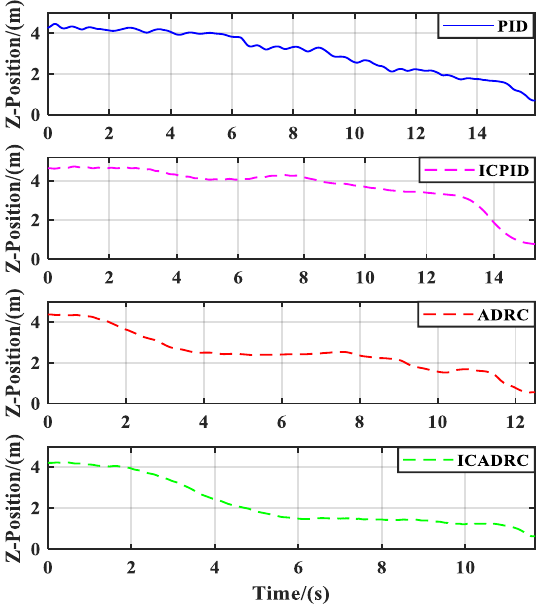
Figure 12. The position changes in Z-direction during landing under different controllers.